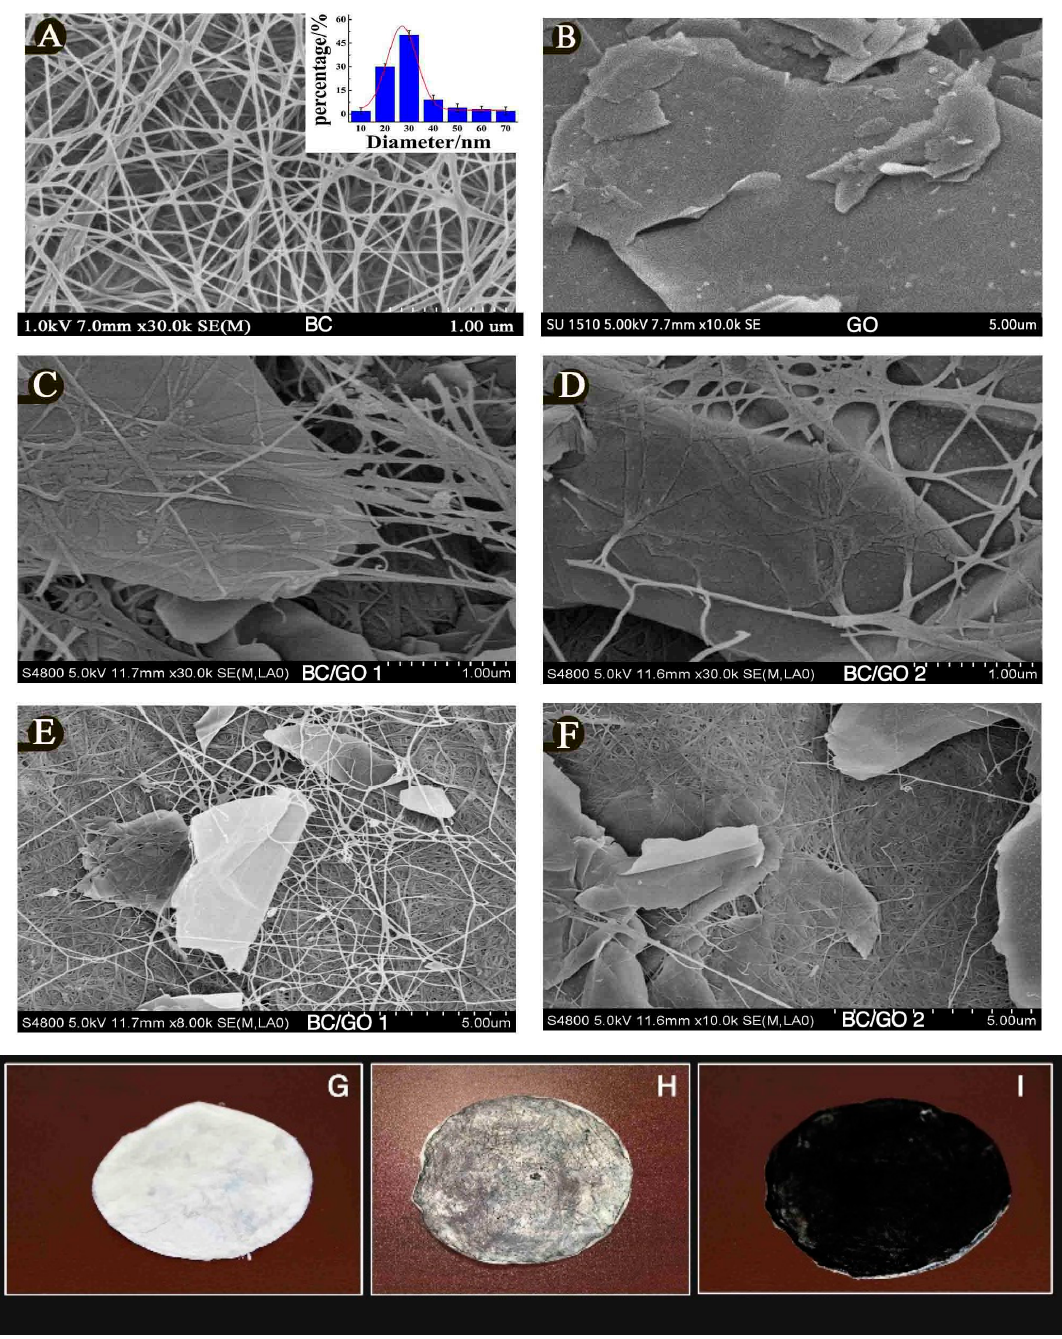
Figure 5. SEM images of samples ( A – F ) at 200x and 10,000x magnification. ( G – I ) Photographed images of final samples; ( G ) pure BC ( H ) BC/GO 1 and ( I ) BC/GO